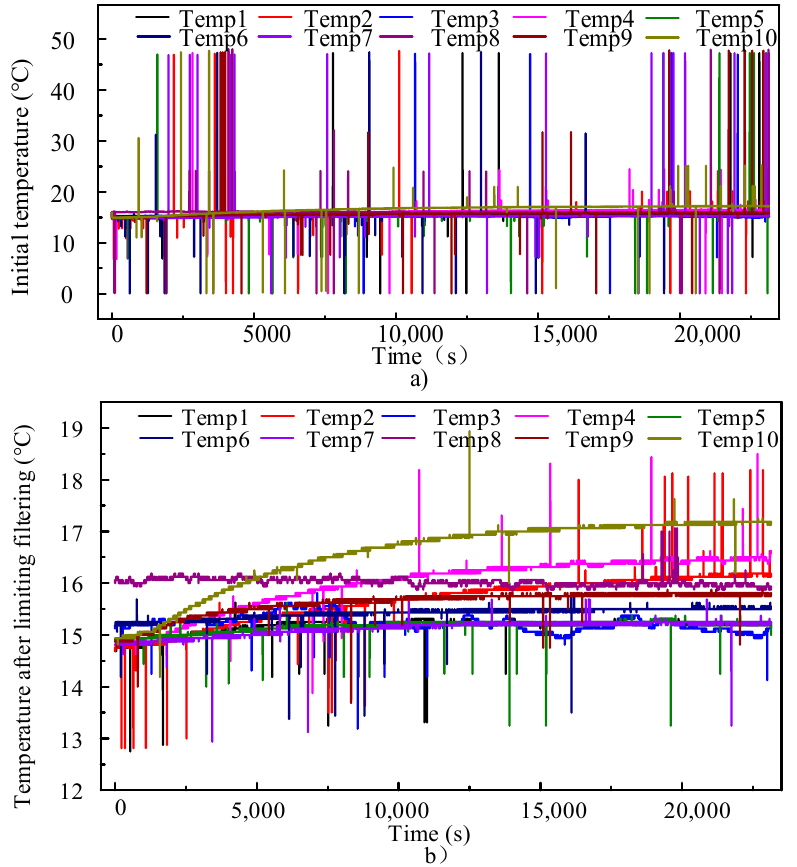
Figure 6. Raw temperature data and limit filtering. ( a ) initial temperature data; ( b ) temperature data after limiting filtering.